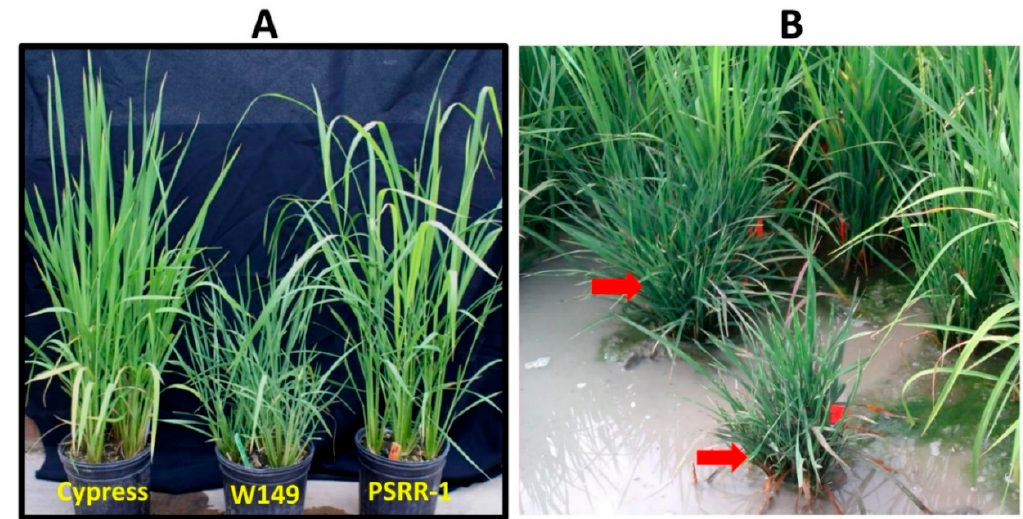
Figure 1. ( A ) Overall morphology of Cypress (Left), W149 (middle), and PSRR-1 (right); ( B ) segregation of mutant and normal plants in field condition. The mutant plants are marked by red